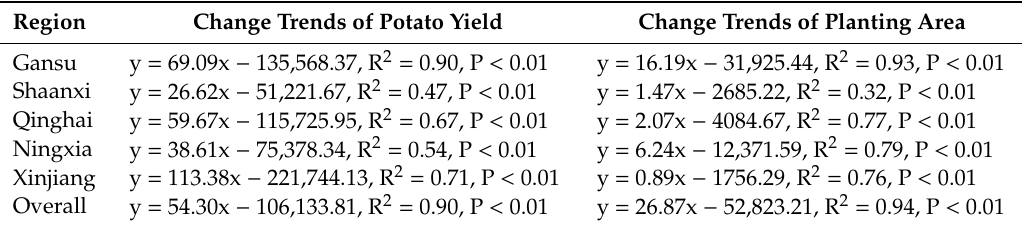
Figure 3. Changes in potato yields and planting areas from 1982 to 2015 in different provinces of northwest China. Table 1. Change trends of potato yield and planting area for each province and overall northwest China from 1982 to 2015.